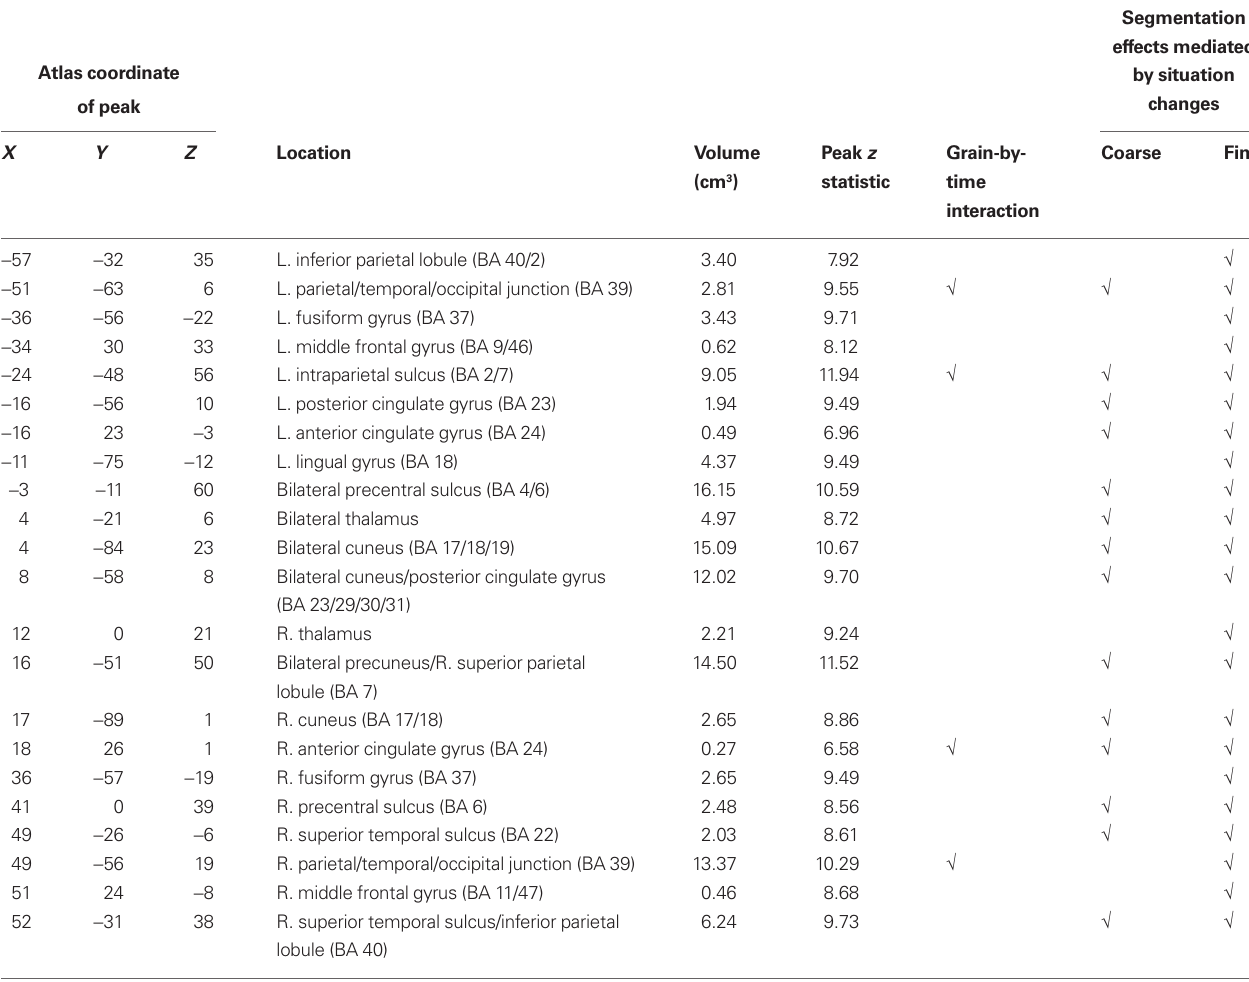
Table 3 | Regions of significant transient fMRI change at event